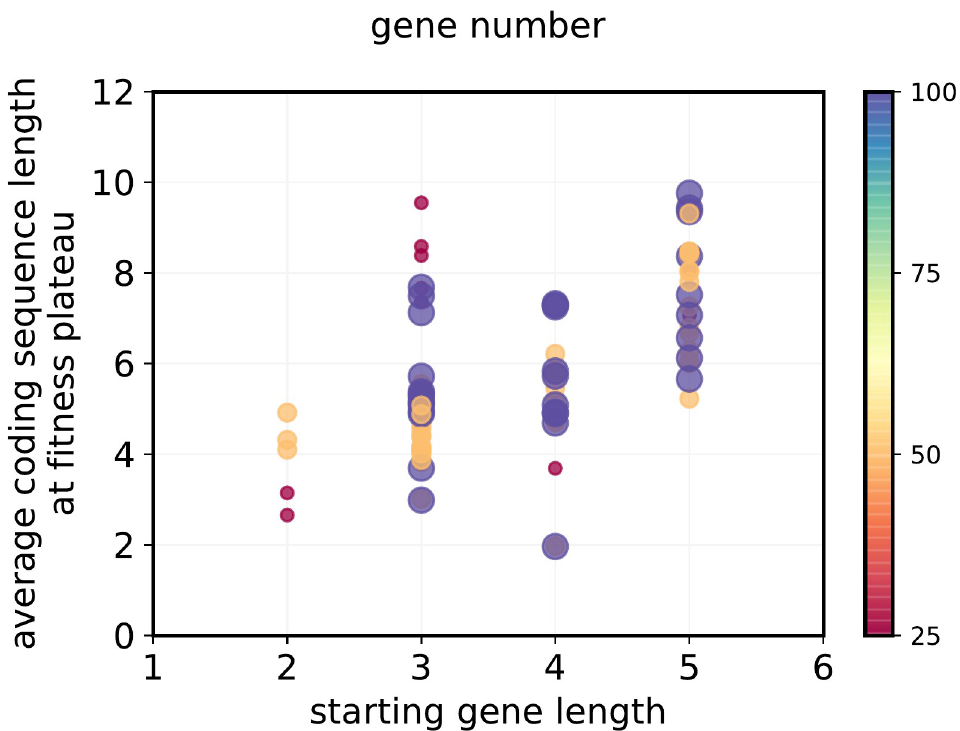
Fig 6. Length of the coding sequences averaged across all genes in a run (Y axis) as a function of the starting length of those sequences (X axis). Circle sizes and color scale show the number of genes in the run, and show no distinct